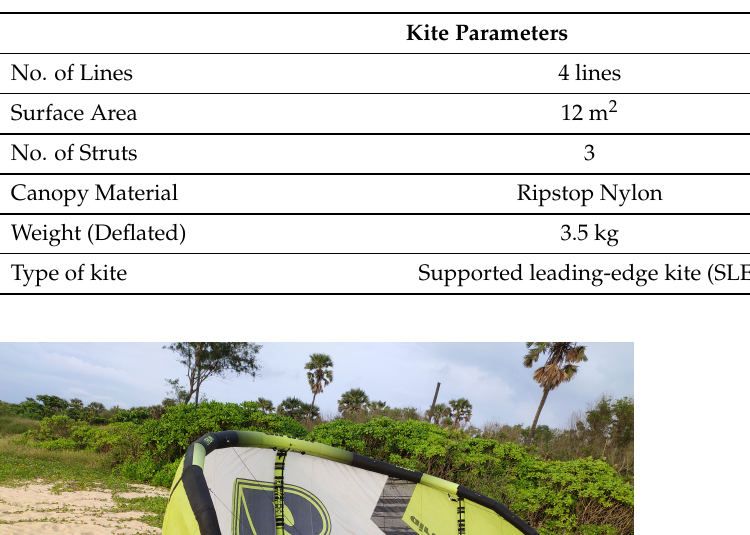
Table 1. Kite Specifications.